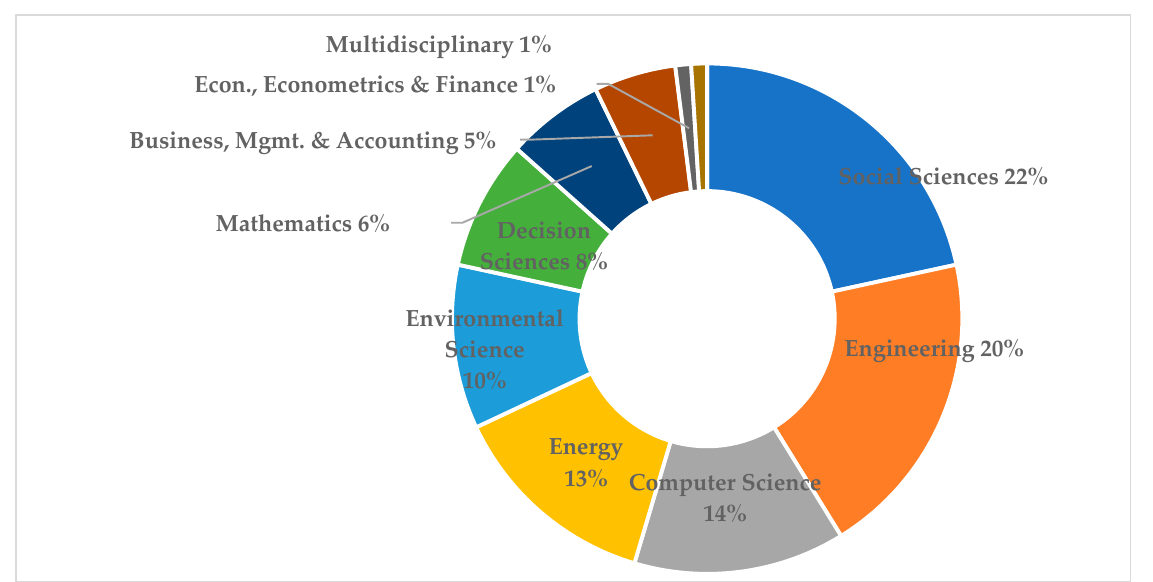
Figure 7. Distribution of papers by subject areas.